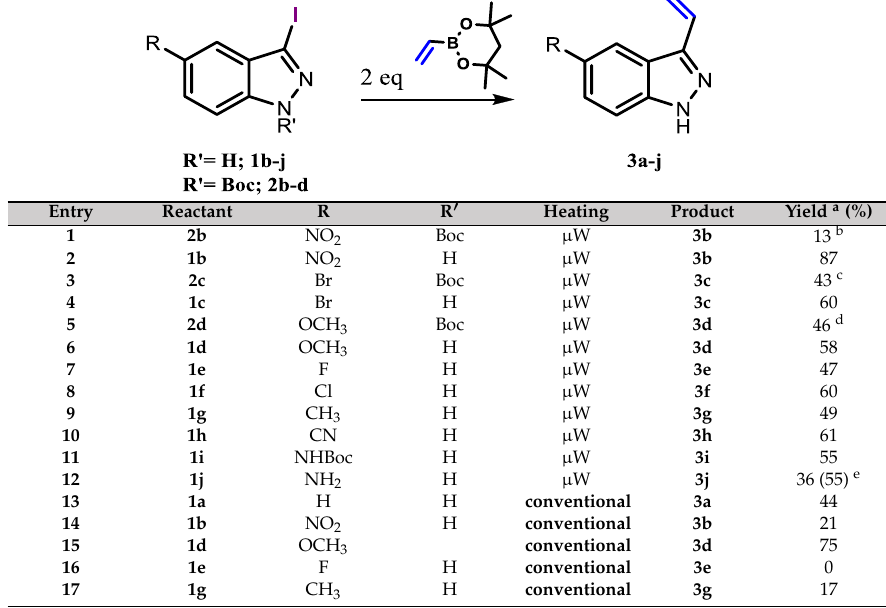
Table 2. Results of the vinylation reaction of several 5-R-3-iodoindazole derivatives.